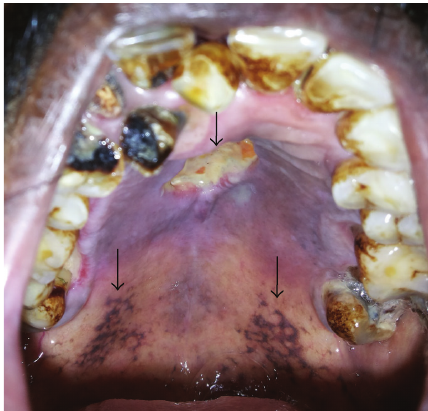
Figure 2: Diffuse oedematous swelling of the palatal mucosa with focal ulceration. Note violaceous discolouration with black pigmented areas over soft palate.